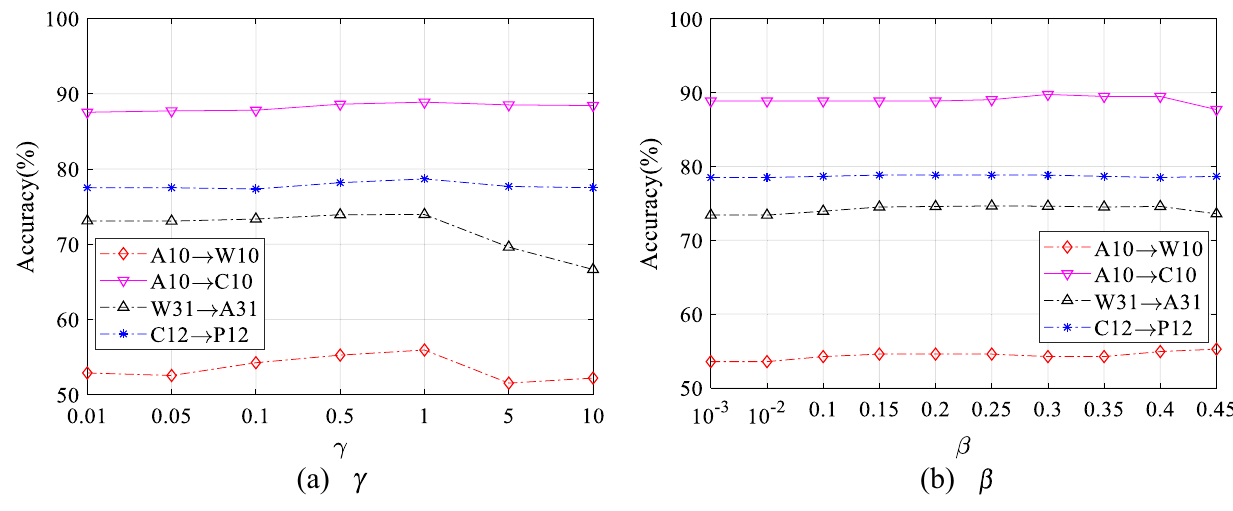
Fig. 6 Parameter sensitivity of DMSP: γ and β